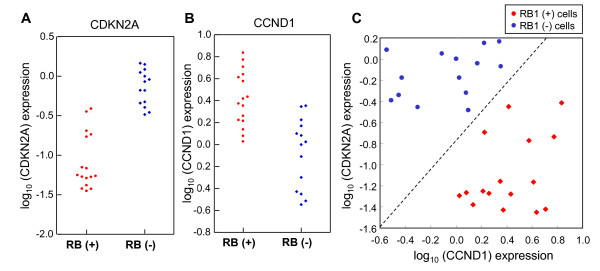
Expression pattern of CCND1 and CDKN2A in RB-positive and -negative cell lines. Correlation between RB1 status and CDKN2A (A) or CCND1 (B) expression level derived from microarray data. (C) Relationship between RB1 status and the ratio of CCND1 to CDKN2A expression derived from microarray data.